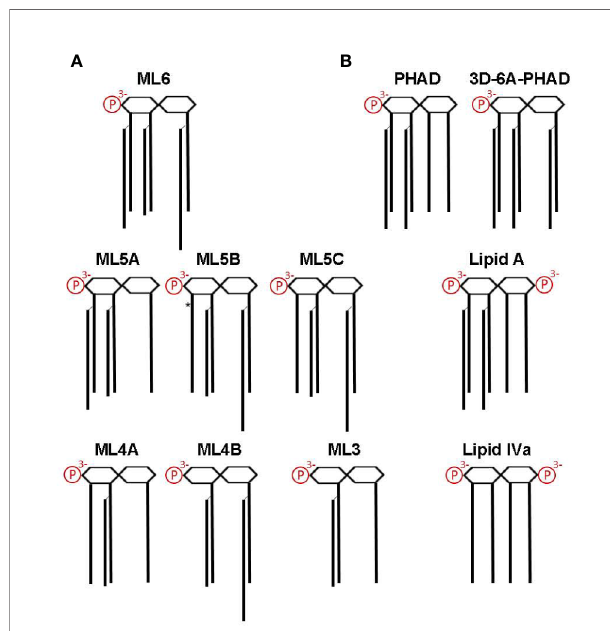
FIGURE 4 | Structures of MPL components and other Lipid A used in this study. Lipid A structures are shown as simpli fi ed diagrams representing a b - (1 ! 6) di-glucosamine backbone with varying numbers of acyl chains and phosphates; 1- and 4 ′ phosphorylation sites are depicted on the right and left, respectively. Amino, ether, ester, and hydroxide linkages are omitted. (A) The major components of MPL adjuvant ® are congeners that differ primarily at the level of acyl chain attachment sites and lengths. All MPL ® adjuvant components lack an acyl chain at the 3-position ( i.e. , are 3-O- deacylated) due to an alkaline hydrolysis processing step. *, denotes location of an unsaturated acyl group that represents the sole difference between ML5B and ML5C. Note that the 2 ′ -position secondary acyl chains are slightly shorter, C12, than the other C14 chains and that the 2-position secondary acyl chain is slightly longer, C16. (B) Structures of synthetic Lipid A used in this study. PHAD (phosphorylated hexa-acyl disaccharide) is a synthetic 4 ′ - monophosphorylated lipid A with six C14 acyl chains in the E. coli con fi guration (2:2:1:1); 3D-6A-PHAD is a synthetic 3-O-desacylated variant in the same con fi guration as ML6 (2:2:0:2) but with uniform acyl chain lengths. Lipid A, synthesized with six acyl chains and 1-, 4 ′ -phosphates, is highly potent agonist of both mouse and human TLR4; Lipid IVa, synthesized with four primary acyl chains and 1-, 4 ′ -phosphates, is an agonist of mouse TLR4 but a potent antagonist of human